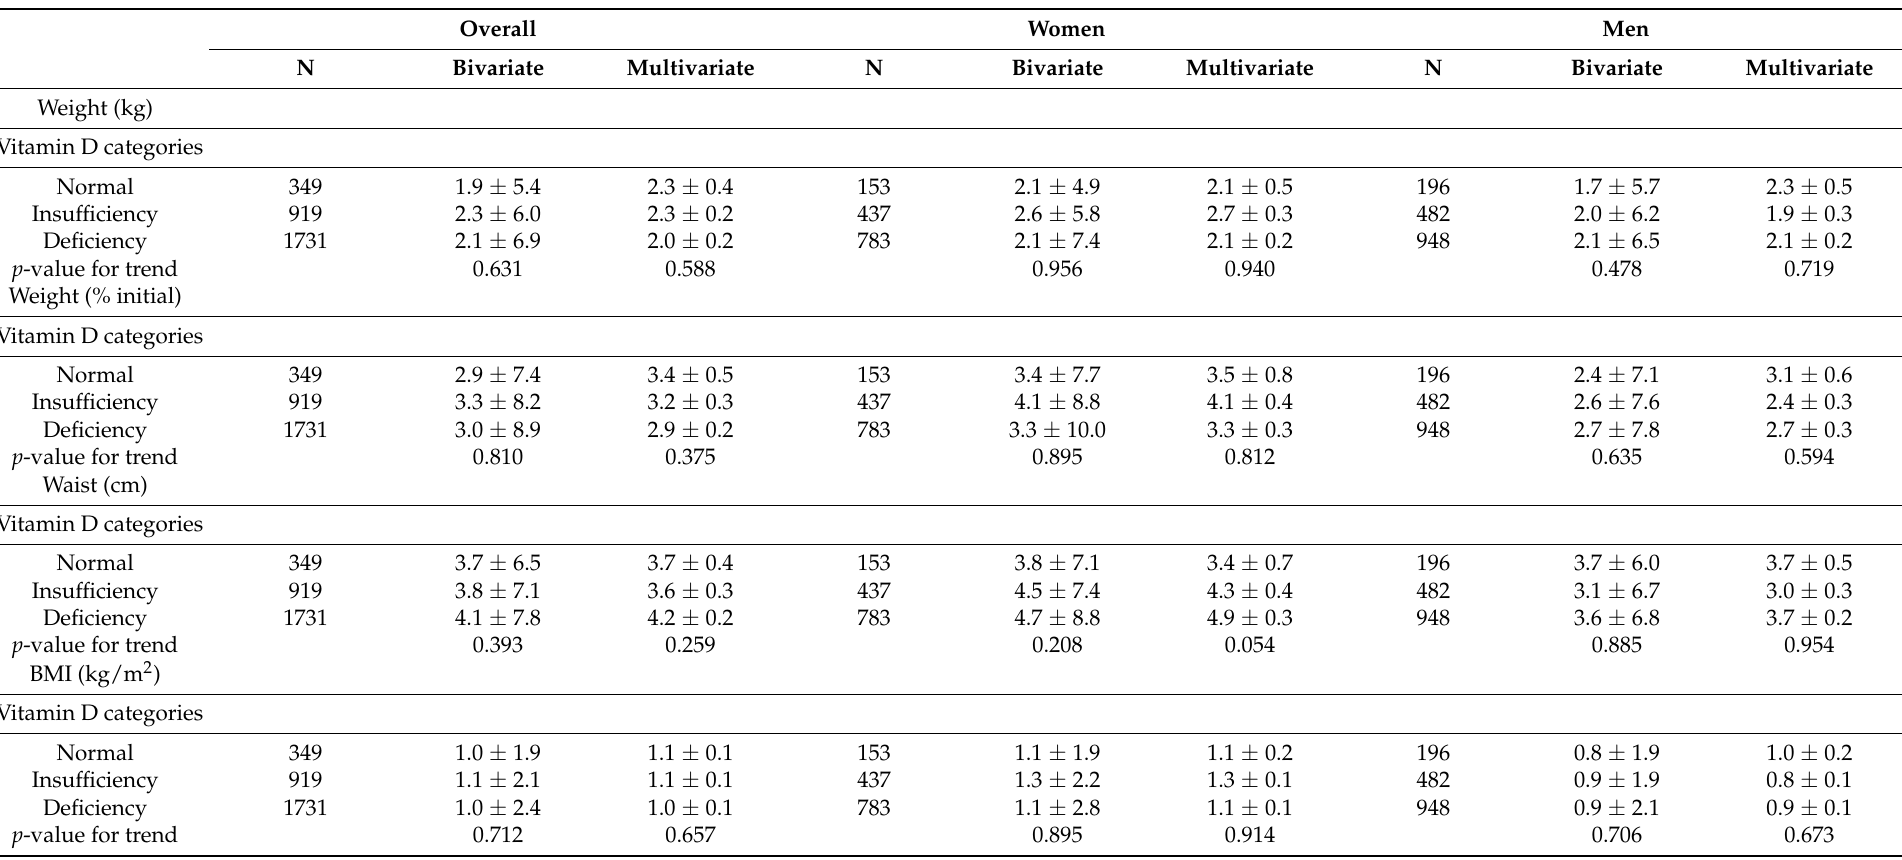
Table 2. Bivariate and multivariate comparisons of 10-year changes in weight and waist according to baseline vitamin D categories, overall and by sex, Co- Laus|PsyCoLaus study,